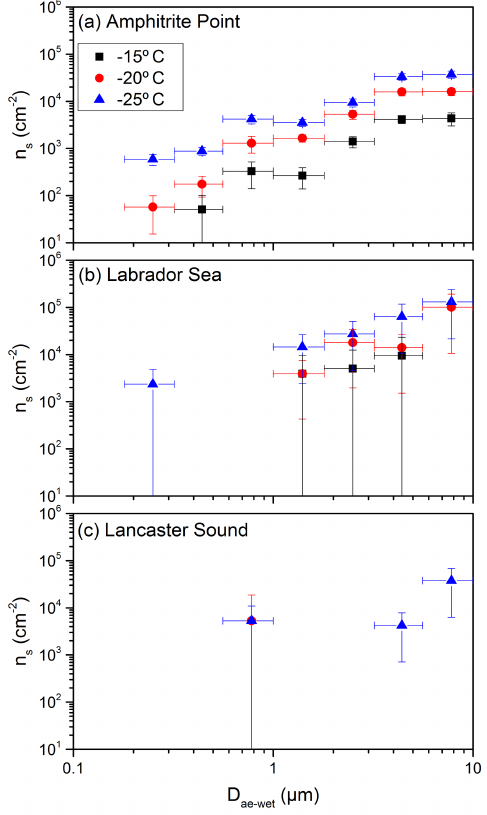
Figure 5. The fraction of aerosol particles acting as an INP (INP /N aerosol ) plotted as a function of aerodynamic diameter ( D ae ) at − 15, − 20, and − 25 ◦ C, respectively, where N aerosol is the num- ber of aerosol particles in a given size bin. The plotted x values represent the midpoints of the size bins from the MOUDI. The x er- ror bars represent the widths of the size bins, and the y error bars are the propagated uncertainties from INP concentrations as a function of size (Fig. 3) and aerosol number concentrations as a function of size (Fig. S4a). In some cases, the y error bars are smaller than the size of the symbols.